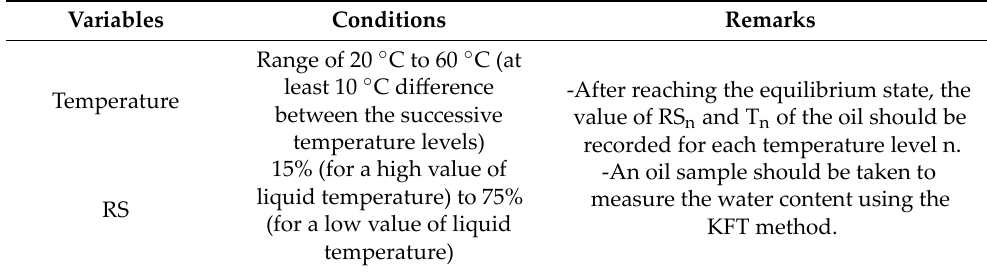
Table 4. Measurement procedure to determine coefficients A and B of insulation